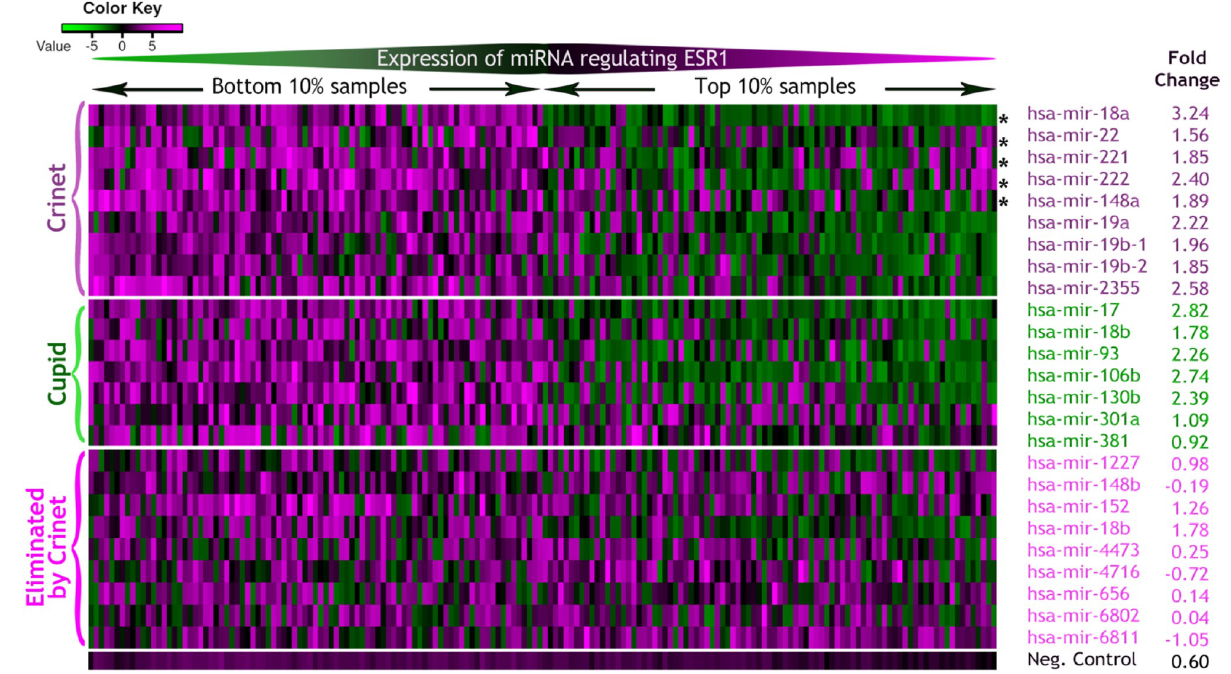
Fig 2. Heatmap showing protein expression of ESR1 for the top and bottom 10% ranked samples with respect to miRNA expression. Protein expression is shown for the top and bottom 10% samples ranked with respect to miRNA expression regulating ESR1 by Cupid-selected, Crinet-selected, Crinet-eliminated, and negative control along with the mean difference of log fold-change of protein expression for the bottom 10% with respect to the top 10% samples. Each row is independently ranked by miRNA expression. ( � Common miRNA regulators with Cupid).